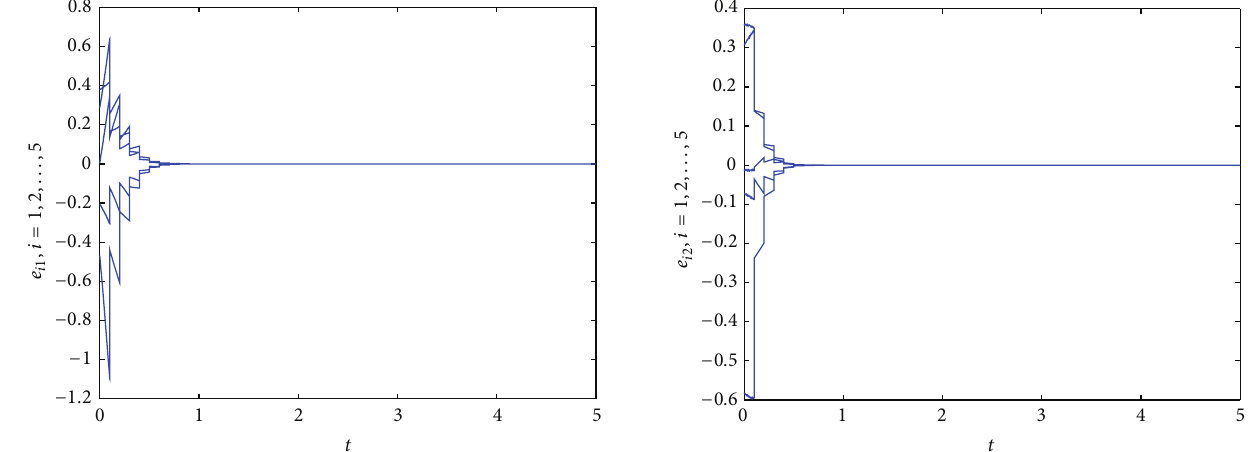
Figure 1: Time evolution of synchronization errors 𝑒 𝑖1 (𝑡), (𝑖 = 1, 2,. . . , 5) of the asymmetric coupled network (21) with random initial values.